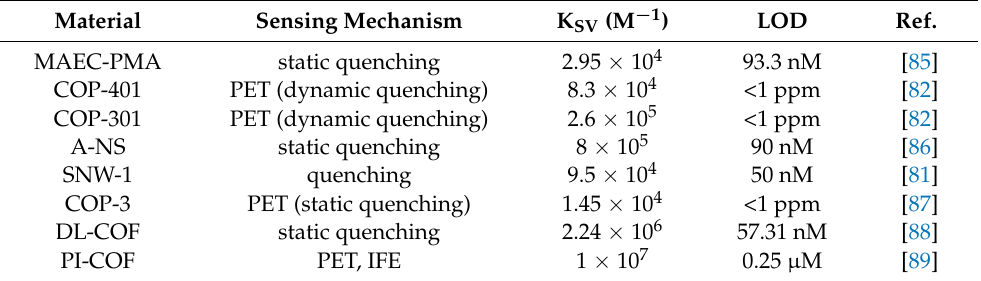
Table 4. Example of COPs and COFs used as nitro high-energetic compounds